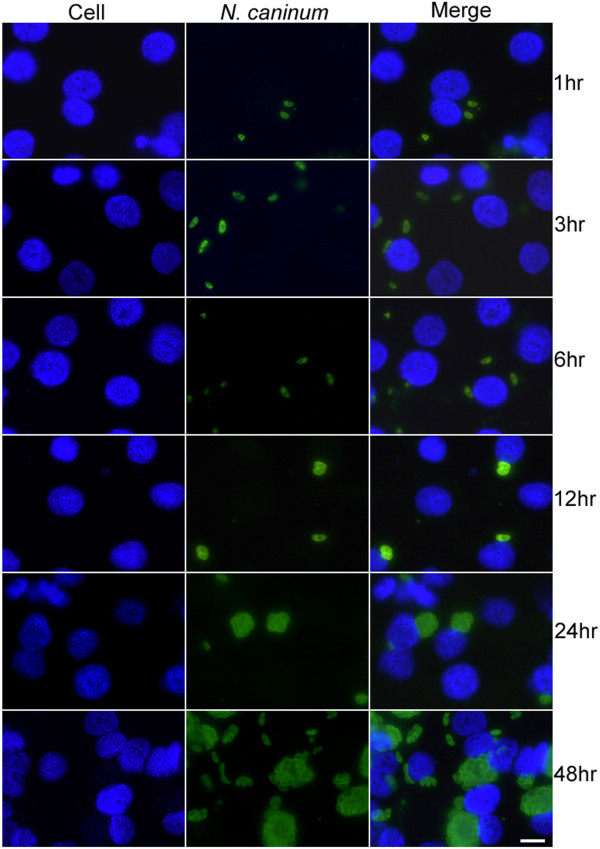
Immunofluorescence staining of human brain microvascular endothelial cells [HBMECs] showing progressive increase in the number of Neospora caninum tachyzoites over time. Cell nuclei [blue] and N. caninum tachyzoites [green]. Staining was performed as described in the methods at various time points post infection as indicated in the figure. (Scale bar = 20 μl.).